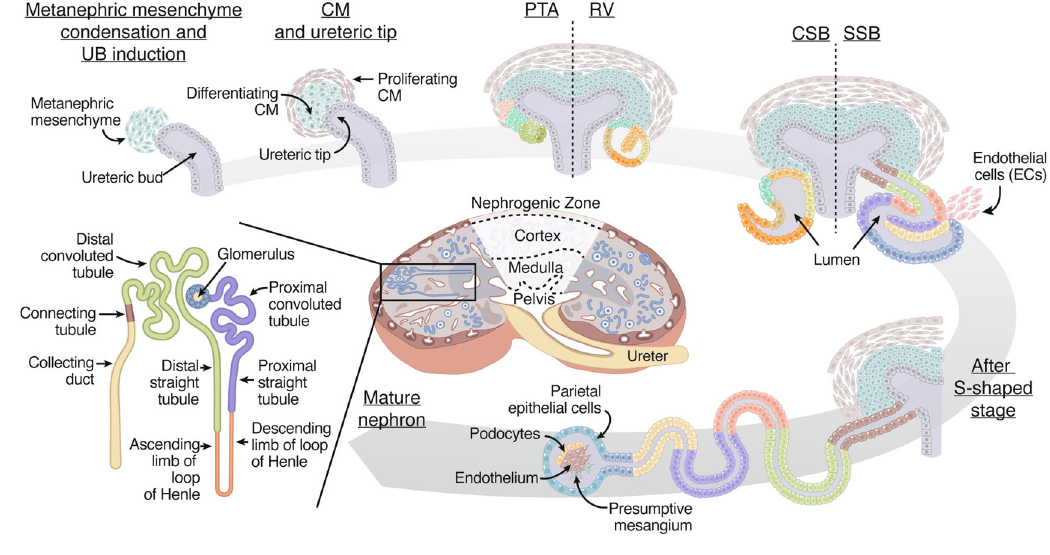
Fig. 1 Schematic representation of nephrogenesis, starting with the interaction of the cap mesenchyme (CM) and ureteric bud (UB) in the nephrogenic zone. Differentiation takes place along morphologically determined stages known as pretubular aggregate (PTA), comma- shaped body (CSB), renal vesicle (RV), S-shaped body (SSB), and capillary loop stage (CLS) nephron. The mature nephron is located throughout the cortex, whereas the Loop of Henle and collecting duct extend into the